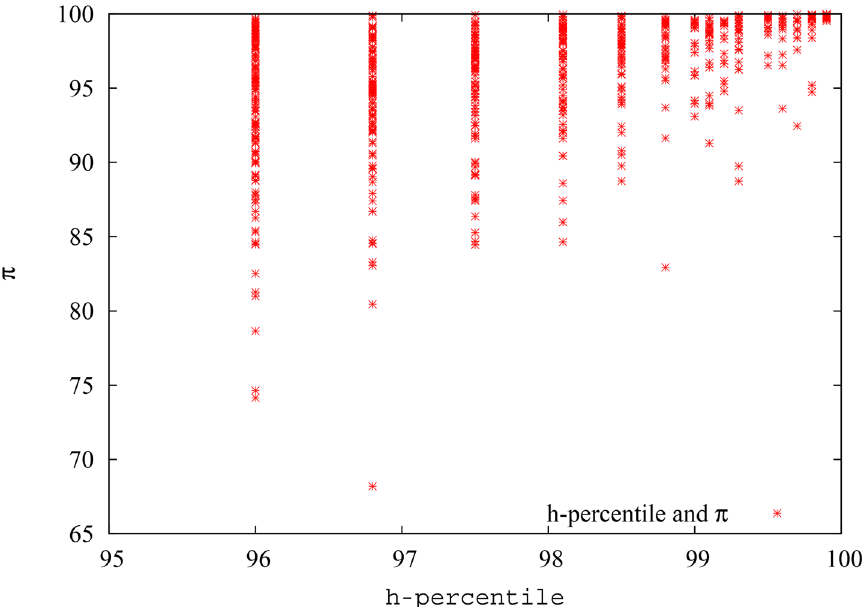
Fig 20. The h-index and pagerank-index of the best 5% authors (in terms of h-index) in the HEP-TH dataset. Since the pagerank-index is a percentile, percentile values were used for the h-index as well, rather than actual h-index values. Note here that the pagerank-index value varies from 65% to 100%. That is, some authors who are among the top 5% in terms of h-index are not even among the top 25% when pagerank- index is